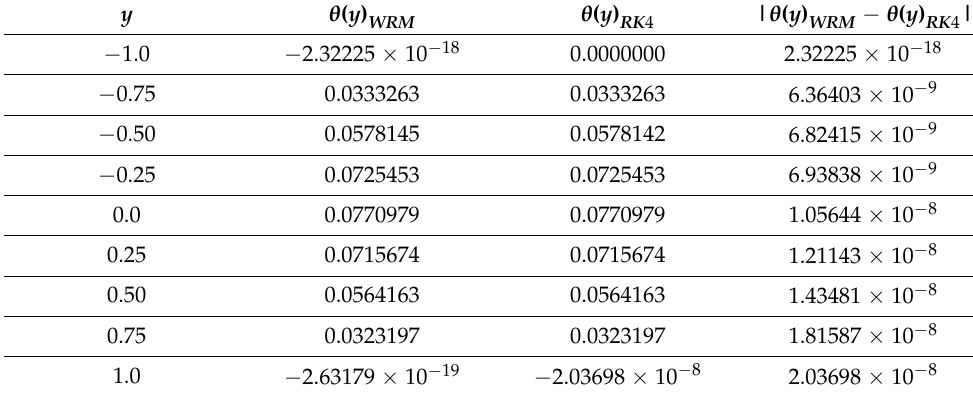
Table 3. Validation of result of Equation (13) when δ = β = γ = H = 1, λ = ε = α = 0.1 .